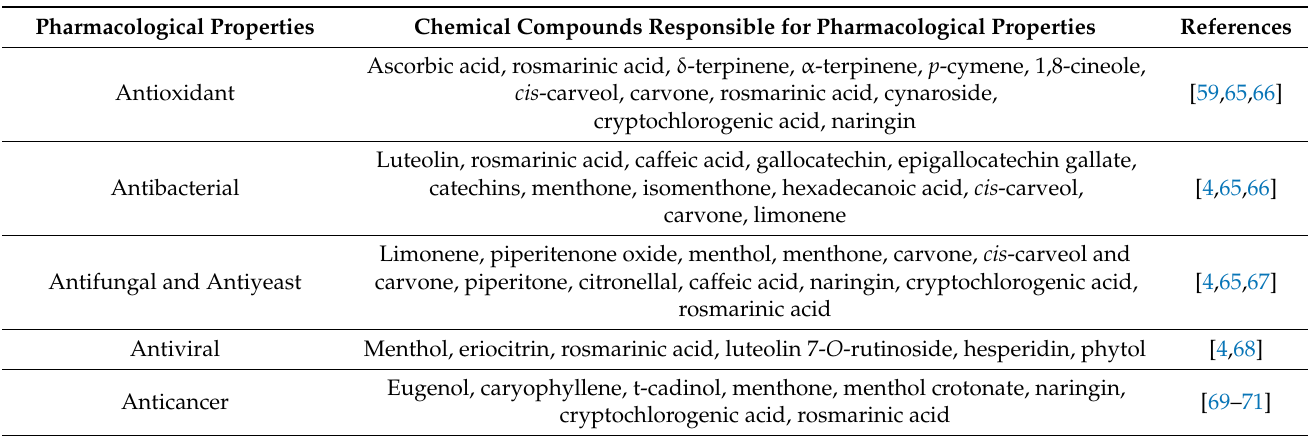
Table 3. Chemical compounds in Mentha genus and their pharmacological properties. Pharmacological Properties Chemical Compounds Responsible for Pharmacological